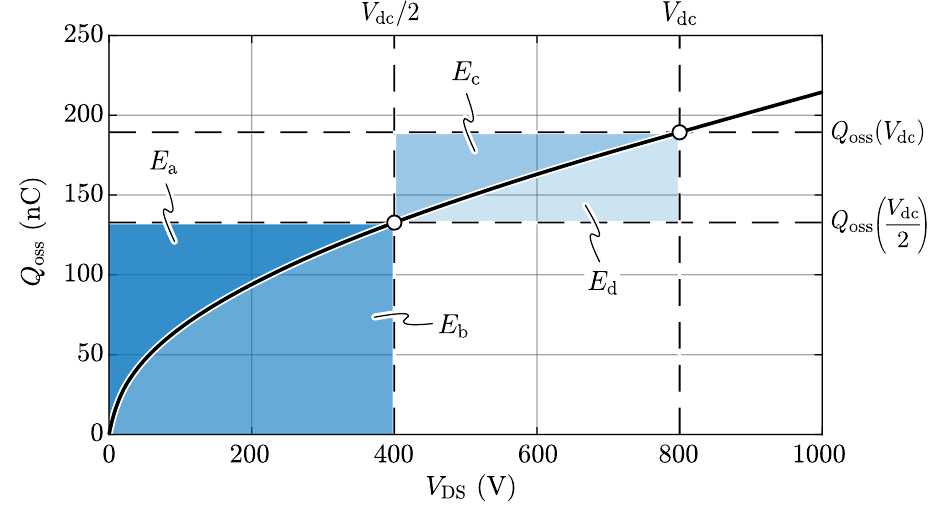
Figure 2. Output charge Q oss dependence on the drain-source voltage V DS of the Wolfspeed C3M0032120K 1200V 32m Ω SiC MOSFET, with highlighted capacitive energy components E a , E b , E c , and E d , assuming V dc =